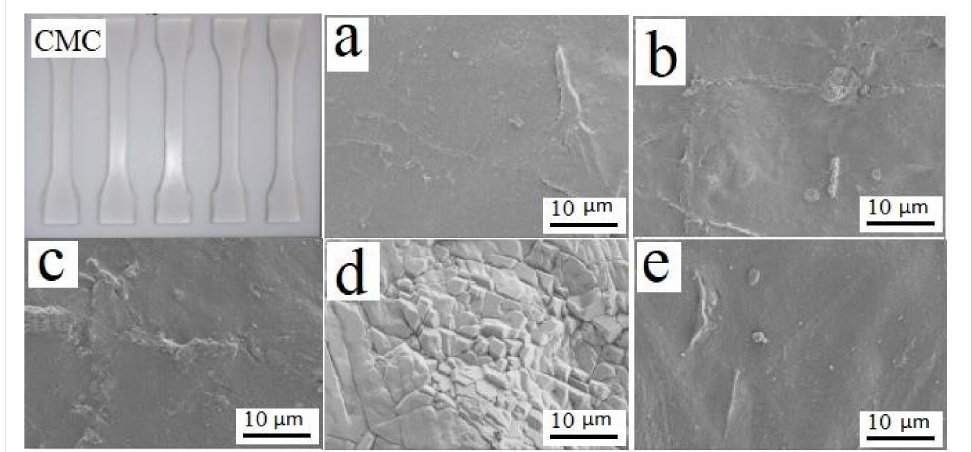
Figure 2. Example of CMC composite dog-bones used to assess tensile strength and scanning electron micrographs of CMC composites derived from ( a ) pine wood, ( b ) bamboo culm, ( c ) pine needles, ( d ) bamboo leaves, and ( e ) hemp hurd, showing slightly different topographies based upon parent